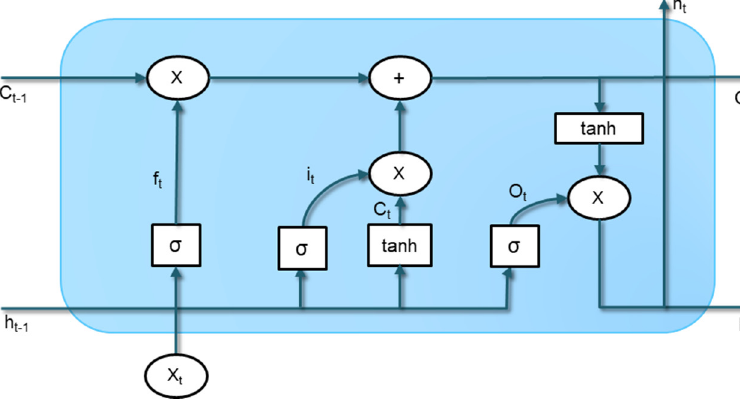
Figure 23. Architecture of basic Long Short-Term Memory (LSTM) unit.